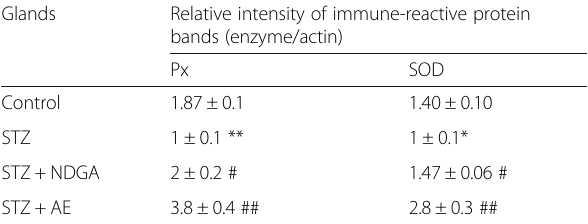
Table 1 Relative intensity of immune-reactive protein bands (enzyme/actin) Glands Relative intensity of immune-reactive protein bands (enzyme/actin) Px SOD Control The relative intensity was determined by densitometry analysis of immunoreactive bands with a software. Control: without treatment,